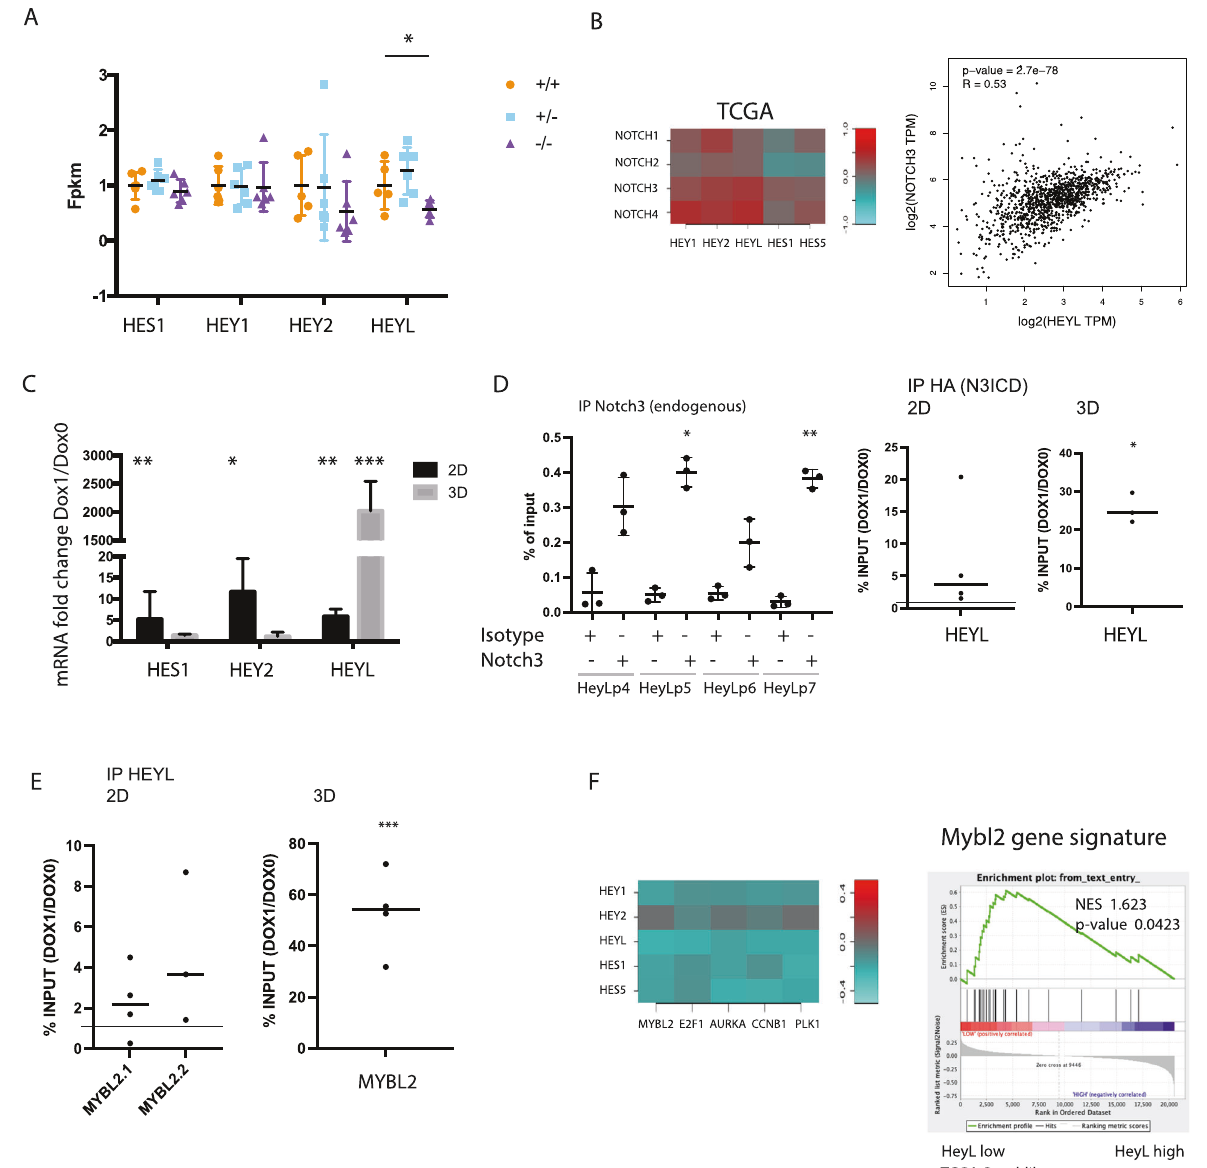
correlation between expression of Notch receptors and Notch traget genes in the TCGA-BRCA dataset and correlation between Notch3 and HeyL. C Expression of HES1, HEY2 and HEYL following N3ICD induction in MDA-MB231 cultured in 2D or in organoïds (3D) ( n = 3 in each conditions). D PCR for HEYL promoter using 4 different sets of primers were realized in chromatin immunoprecipitated with Notch3 antibody in MCF7 cells ( n = 3 for 4 pairs of primers) and with HA antibody in MDA-MB231 cells treated with Doxycyclin (DOX1) to induce N3ICD compared with non induced cells (DOX0) in 2D ( n = 4 with one pair of primers and in 3D (one experiment with 3 different pairs of primers). E PCR for MYBL2 promoter after immunopreicipitaion of HeyL using two different set of primers in 2D ( n = 4 for each pairs of primers) and in 3D with 4 different pairs of primers in one experiment. F Pearson coef fi cient of correlation between Notch target genes and Mybl2 in the TCGA dataset and GSEA for the Mybl2 signature comparing the HeyL high and HeyL low basal-like tumors in the TCGA-BRCA